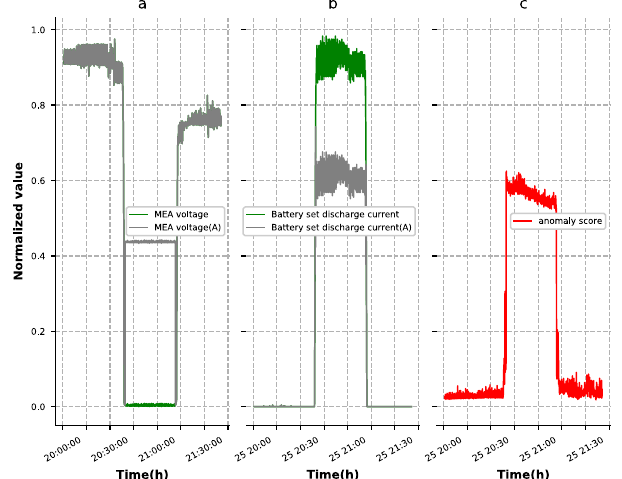
Figure 11. Detection result of the battery set open-circuit failure ((A) indicates the anomalous curve). ( a ) The normal MEA voltage and anomalous MEA voltage. ( b ) The normal battery set discharge current and anomalous battery set discharge current. ( c ) The anomaly score of the reconstruction results.